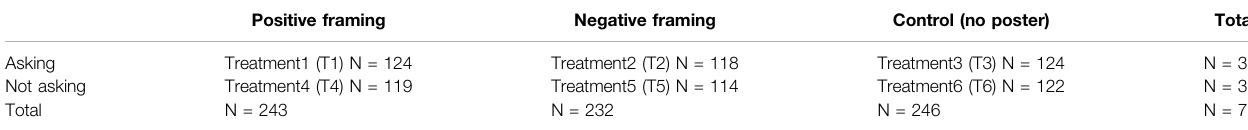
TABLE 1 | Sample size by treatment allocation.